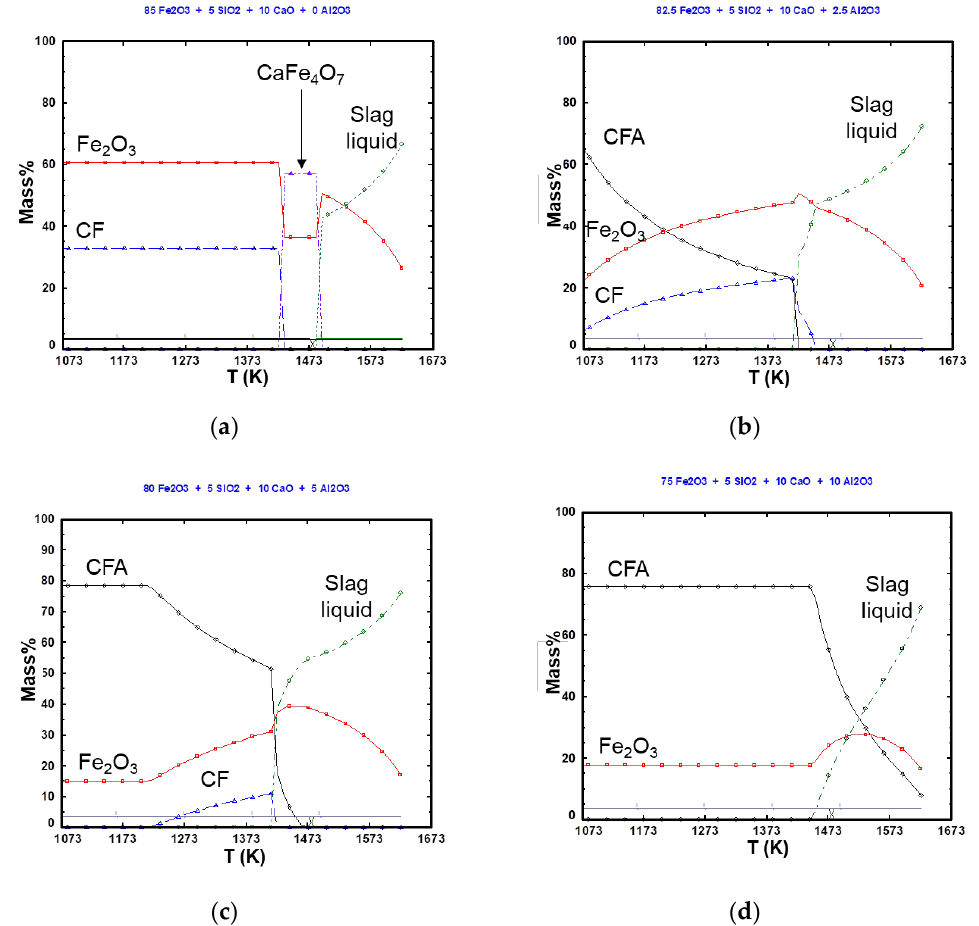
Figure 9. Variation of the equilibrium phase fractions in the Fe 0 O 3 -CaO-SiO 2 -Al 2 O 3 system with the temperature, calculated using Factsage 8.0: ( a ) 0 mass% Al 2 O 3 , ( b ) 2.5 mass% Al 2 O 3 , ( c ) 5 mass% Al 2 O 3 , and ( d ) 10 mass% Al 2 O 3 .